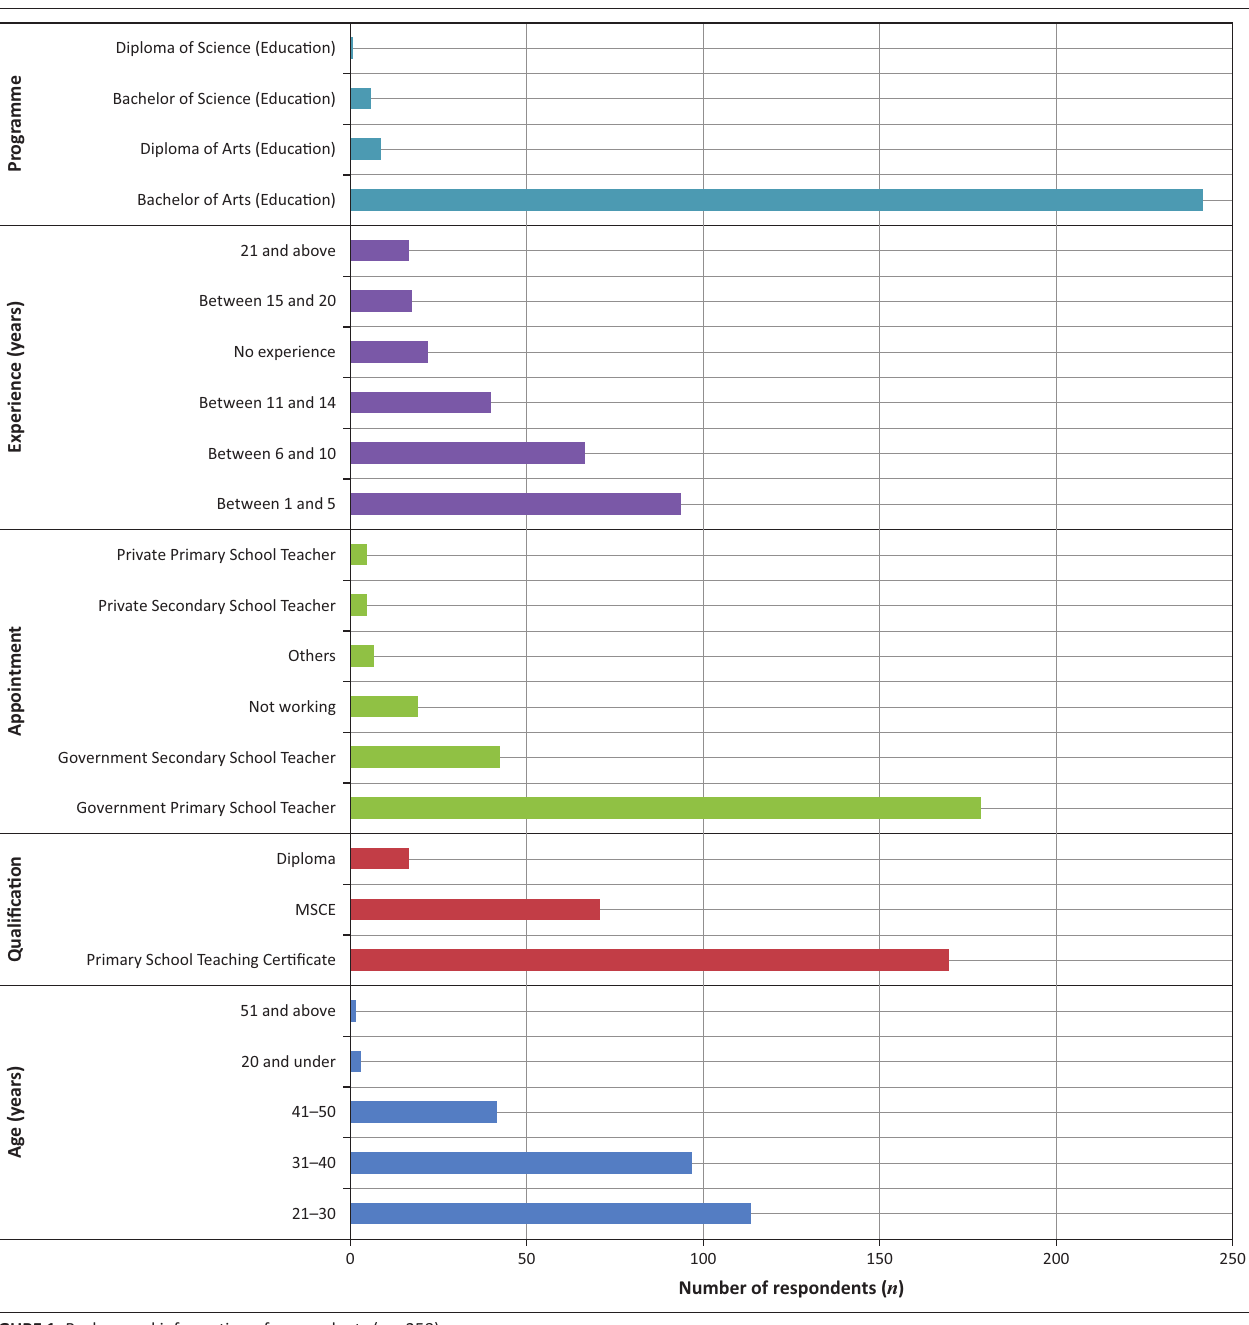
FIGURE 1: Background information of respondents ( n =